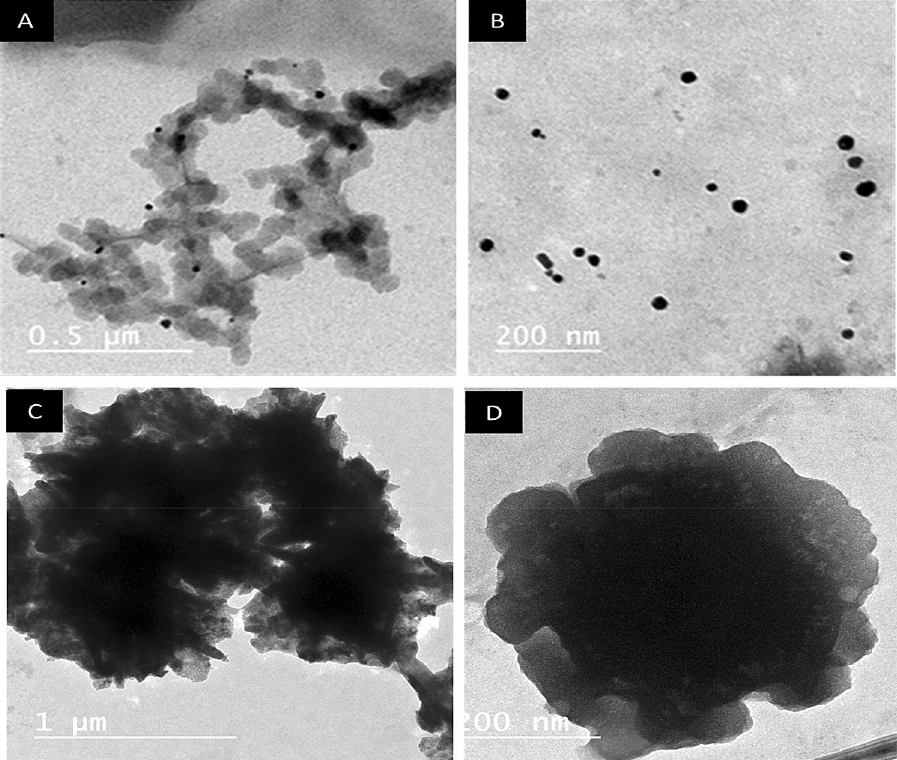
Figure 1. TEM of Ag NPs ( A , B ) and Zn NPs ( C , D ) at low and high magnifications power.